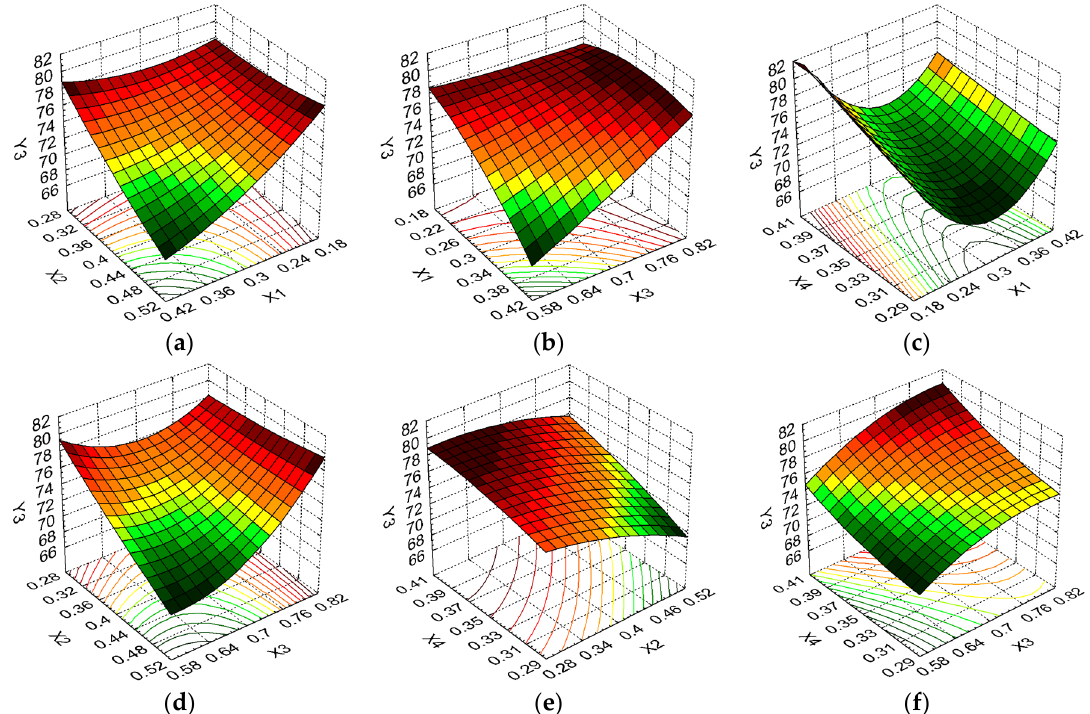
Figure 7. The 3D response surface and contour plot showing the effect of different formulation factors on the microcapsule drug encapsulation efficiency ( Y 3 ): ( a ) collagen concentration ( X 1 ) and NaCMC concentration ( X 2 ); ( b ) collagen concentration ( X 1 ) and sodium alginate concentration ( X 3 ); ( c ) collagen concentration ( X 1 ) and doxycycline concentration ( X 4 ); ( d ) NaCMC concentration ( X 2 ) and sodium alginate concentration ( X 3 ); ( e ) NaCMC concentration ( X 2 ) and doxycycline concentration ( X 4 ); ( f ) sodium alginate concentration ( X 3 ) and doxycycline concentration ( X 4 ).